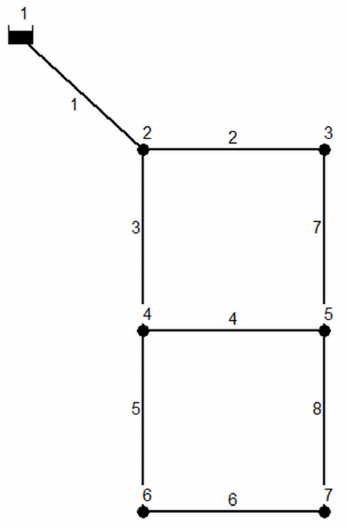
Figure 1. Layout of two-loop network, TLN